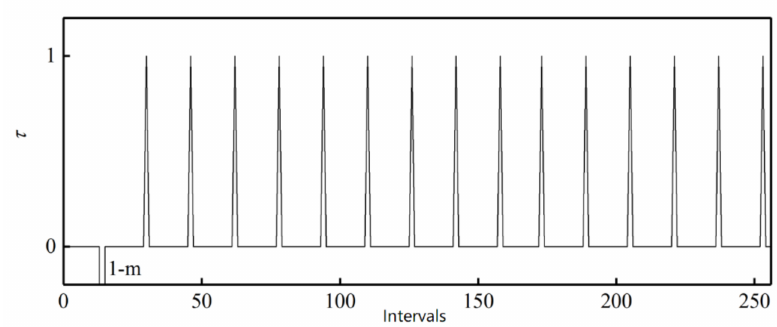
Figure 9. Differences of all intervals.